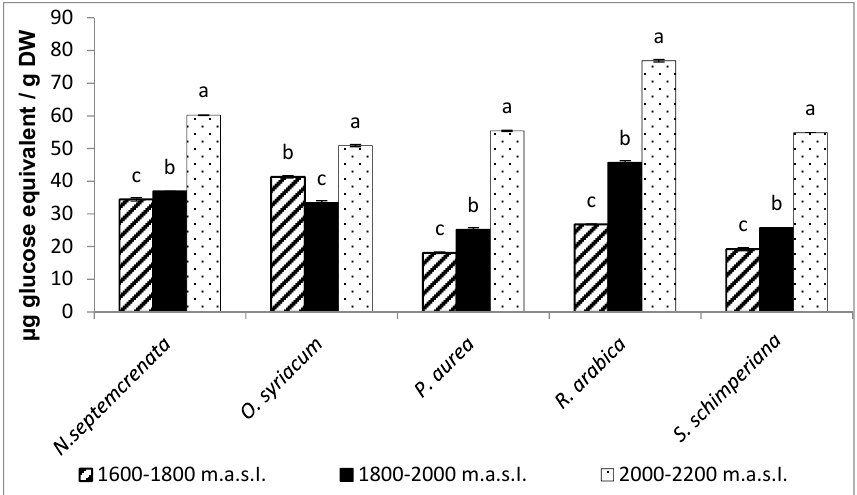
Figure 3. Effect of altitude on the total soluble sugars. Each value is the mean of three replicates ± SE. Bars with different letters are significantly different at p ≤ 0.05.